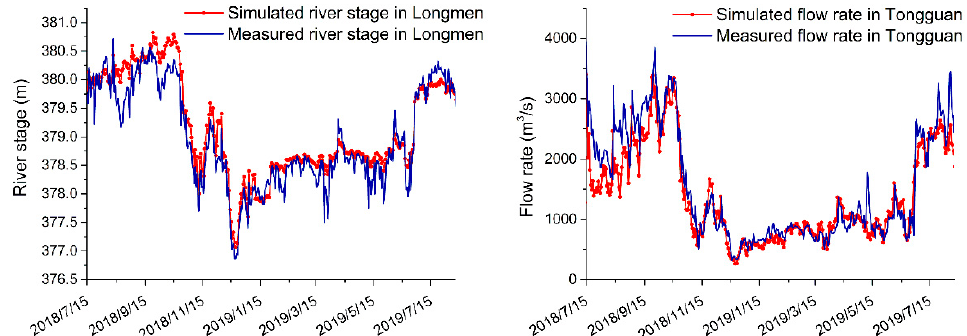
Figure 6. Comparison of the simulated and the measured data for the river stage at the Longmen gauging station on the left panel and the river flow rate at the Tongguan gauging station on the right panel.